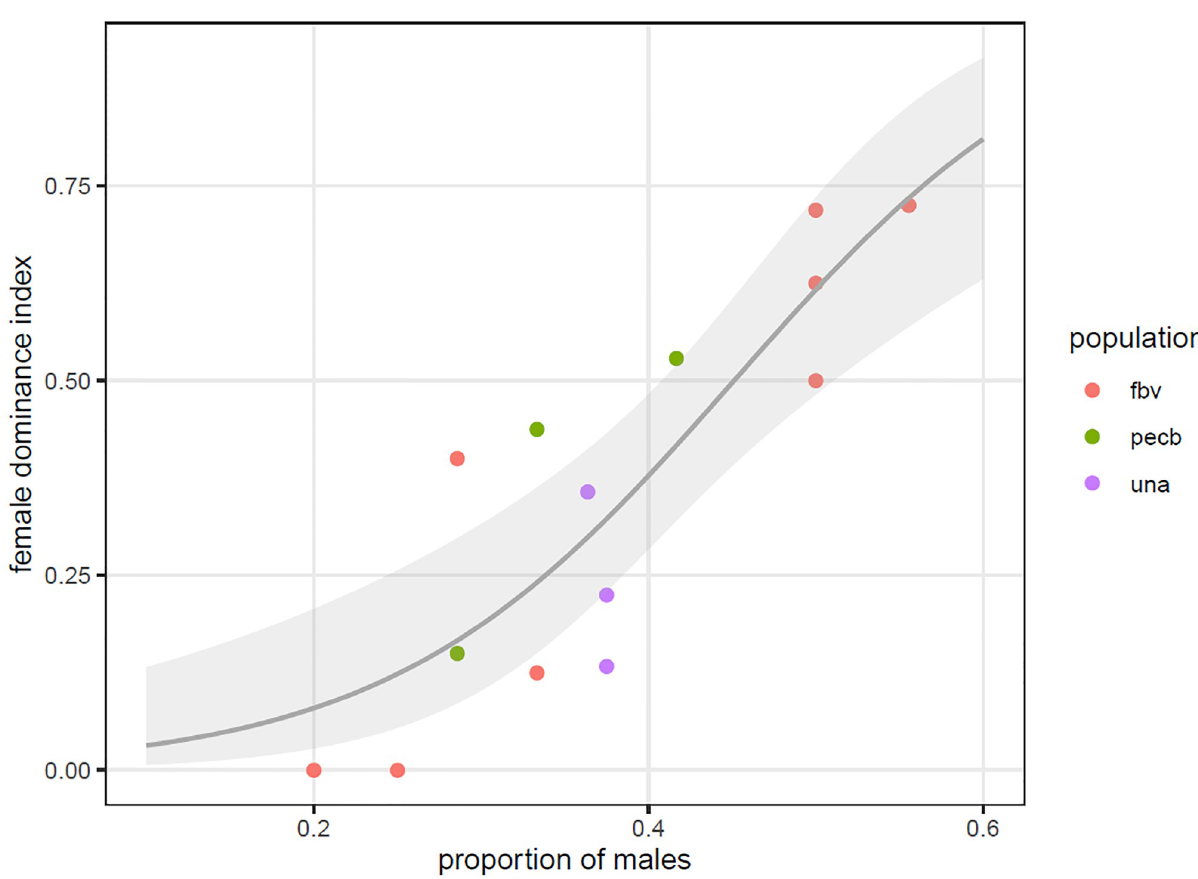
Fig 1. Degree of female dominance as a function of proportion of males per group in 14 hierarchies of robust capuchin monkeys from three wild populations. Degree of female dominance was measured as the proportion of males ranking below females on average (the female dominance index,